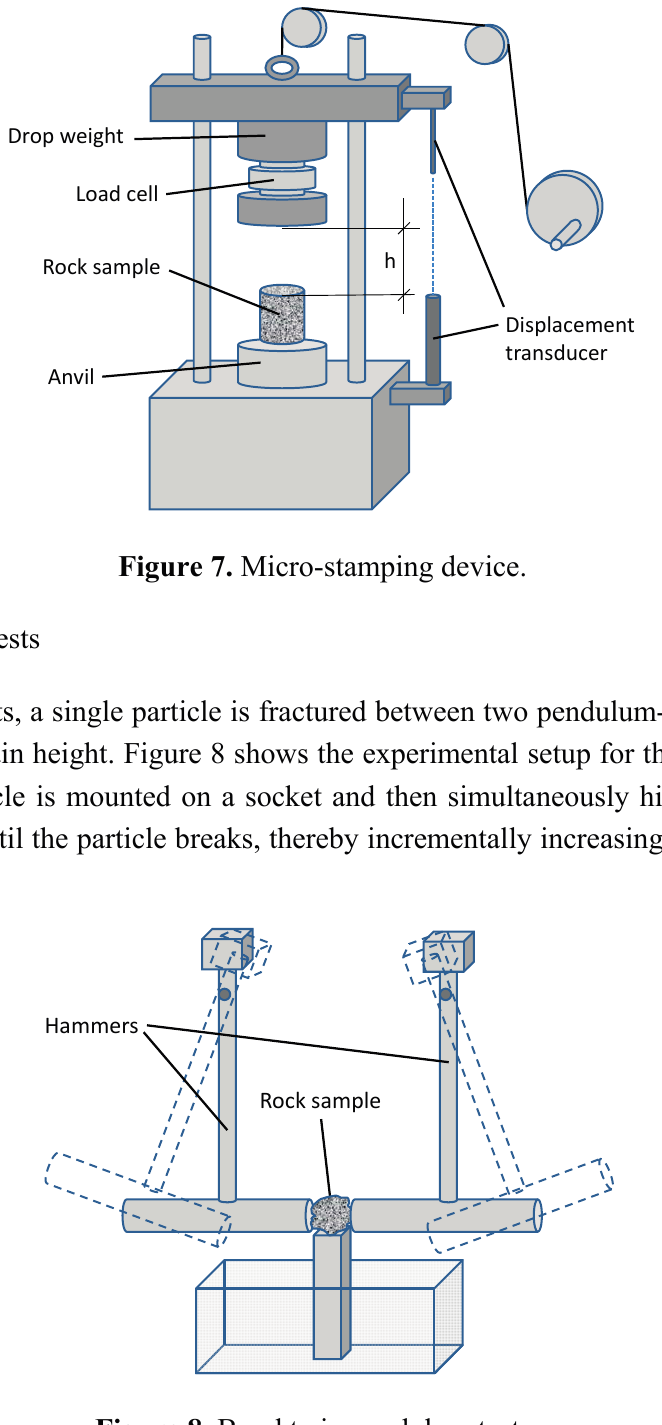
Figure 8. Bond twin pendulum